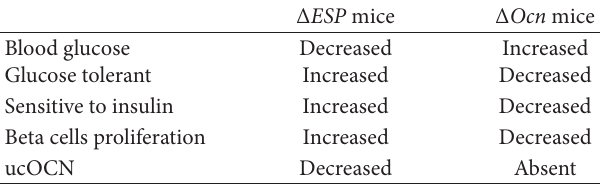
Table 1: Metabolic phenotypes of ESP and Ocn knocked out